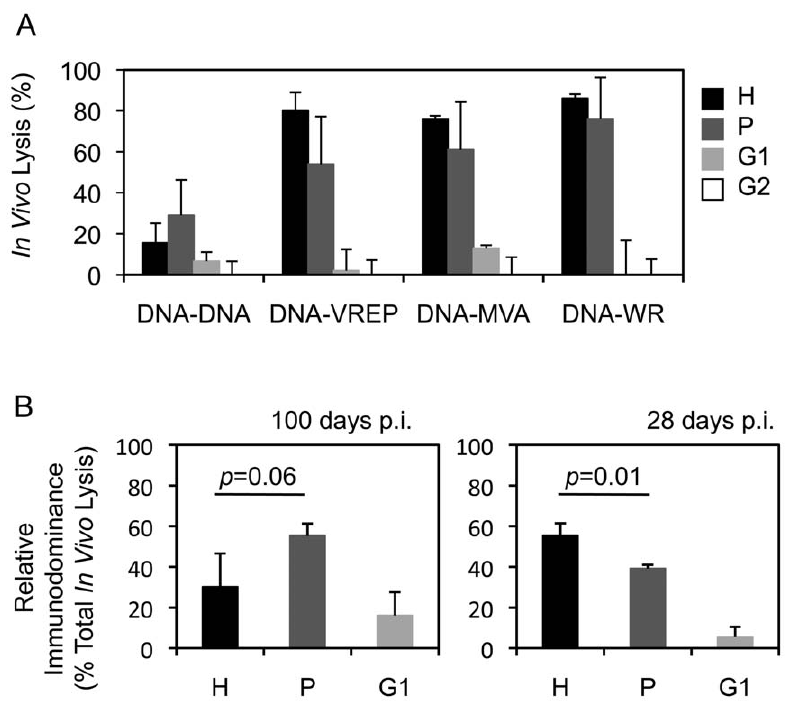
Figure 5. Vector of the boost vaccine influences the epitope hierarchy. A) Groups of 3–4 BALB/c mice were primed with 100 m g of pTHr.HIVA DNA and boosted with the same dose of pTHr.HIVA DNA or 5 6 10 6 PFU of MVA.HIVA, VREP.HIVA or WR.HIVA at a 2-wk interval. Hundred d later, cytolytic activity was assessed in an in vivo lysis assay using syngeneic peptide-pulsed cells in naı¨ve and vaccinated animals. B) Groups of 3 BALB/c mice received 2x 100 m g of pTHr.HIVA DNA 2 wk apart and assessed for the cytolytic activity at 100 (left) or 28 d (right) post-immunization. The relative immunodominance of responses to individual epitopes was calculated as a percentage of the total CD8 + cell response. Results are shown as mean 6 SD. p values for the H and P epitope-specific response comparison are inserted above the columns. Panel B is a repetition of the important observation from panel A. This is further confirmed in Figure 6A.